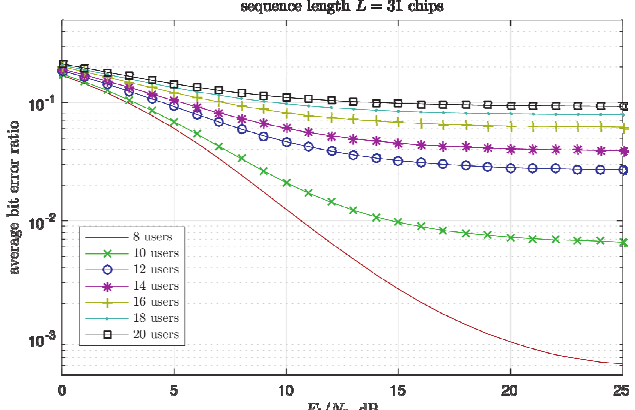
Fig. 7. Asynchronous DS-CDMA: BER performance in case of 31-chip-long chaotic spreading